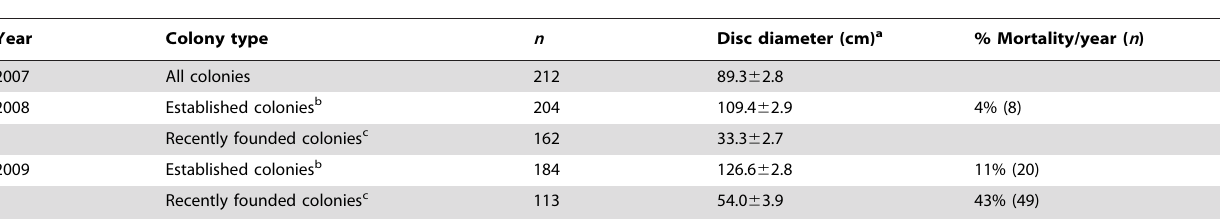
Table 1. Demography of rough harvester ant colonies from